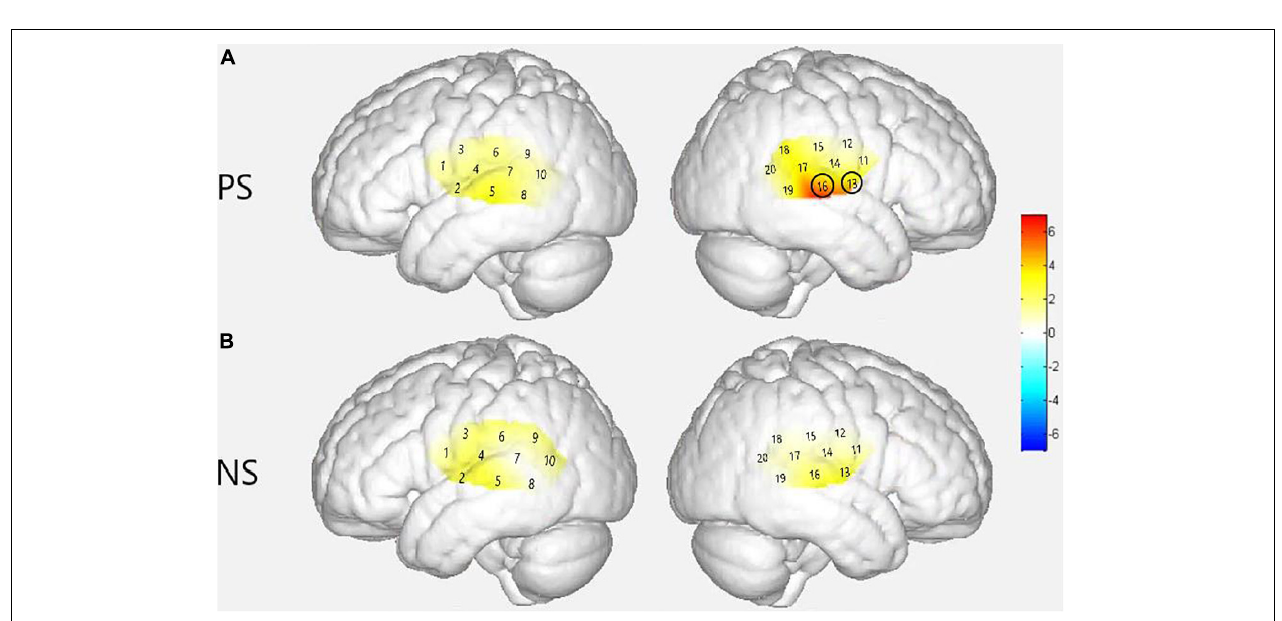
FIGURE 6 | Group level cortical activation maps by contrasting between groups in the views of the normalized brain surface. The color scales represent the F values, with statistically significant activated channels circled in black [ p FRD - cor < 0.05]. (A) Lateral views of significantly activated channels in normal hearing (NH) group under the strong-prosodic (SP) condition than CI. (B) Lateral views of activating difference under the weak-prosodic (WP) condition by contrasting two groups of participants.